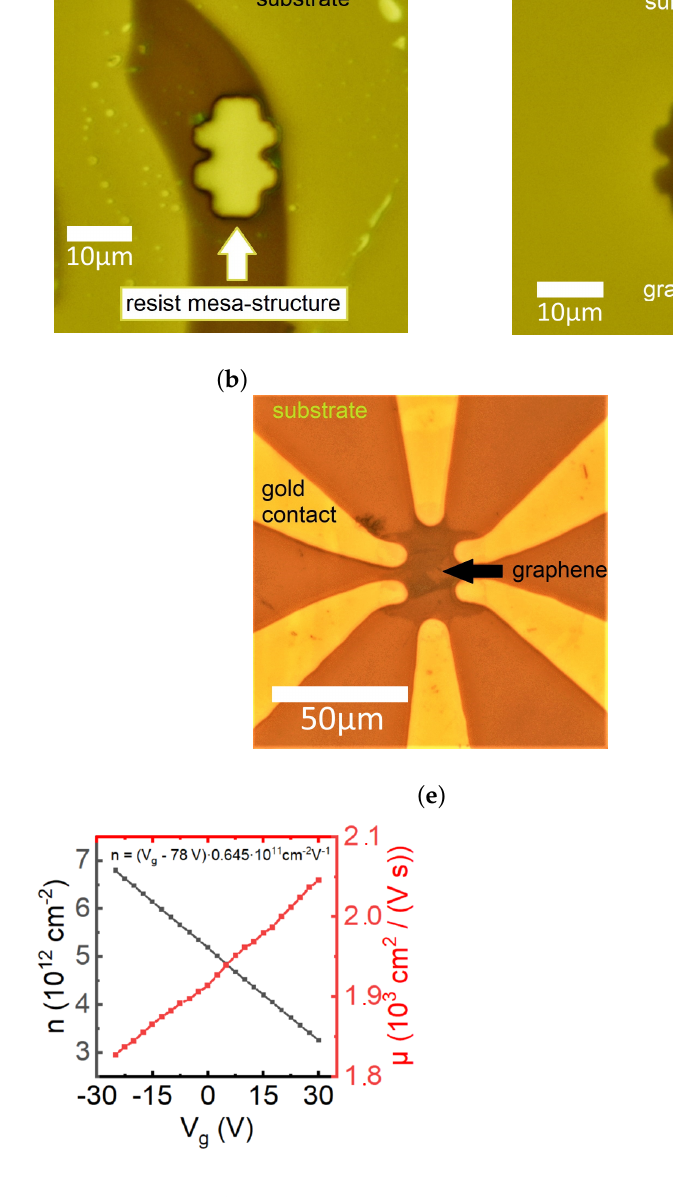
Figure 3. Lithography fabrication stages and examples. Panels ( a – d ) show the mesa-fabrication stages on a few-layer graphene flake. The length of the Hall-bar structure is 18 µ m. ( a ) Alignment of the mesa mask with 40 µ m length graphene flake; ( b ) after the resist developing; ( c ) mesa-structure after the plasma-etching and resist removal; ( d ) micromask-patterned resist for the contacts; ( e ) example of the 50 µ m length graphene monolayer Hall-bar mesa-structure with top- evaporated gold contacts, ( f ) Hole density and mobility measured from the Hall effect in the graphene sample at 4